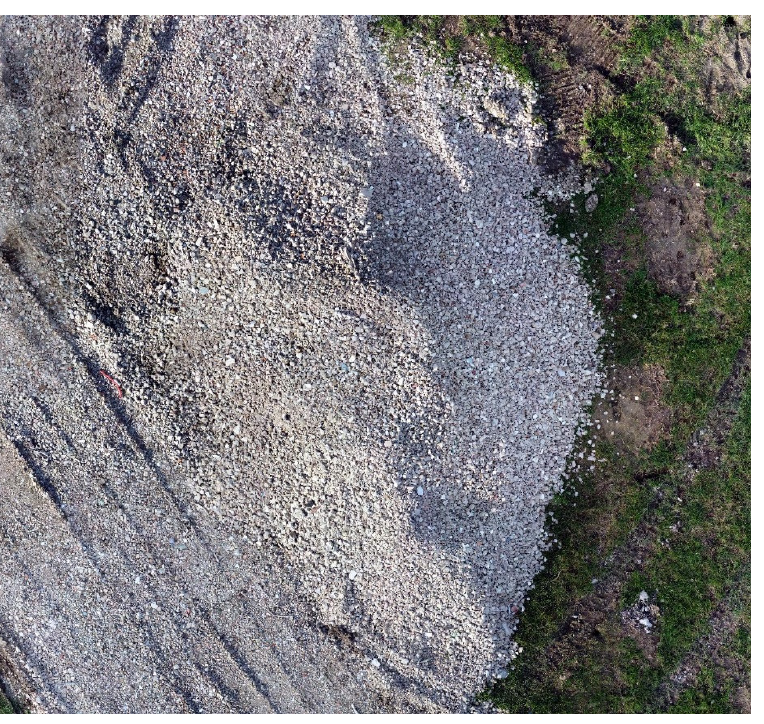
Figure 9. Construction site, orthophoto.